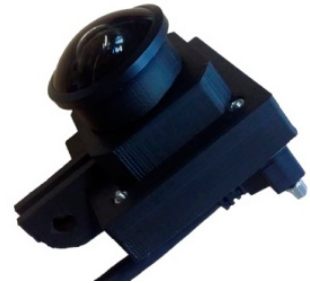
Figure 4. Low-cost IDS camera UI-3251LE-M-GL, resolution: 1600 by 1200 pixels at 60 Hz.